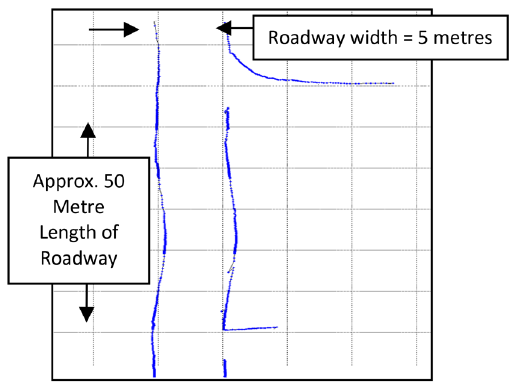
Fig. 9 Laser-reconstructed 2D view of the test site showing cut- throughs: note that the vertical scale is compressed in order to show detail of the horizontal features on a single